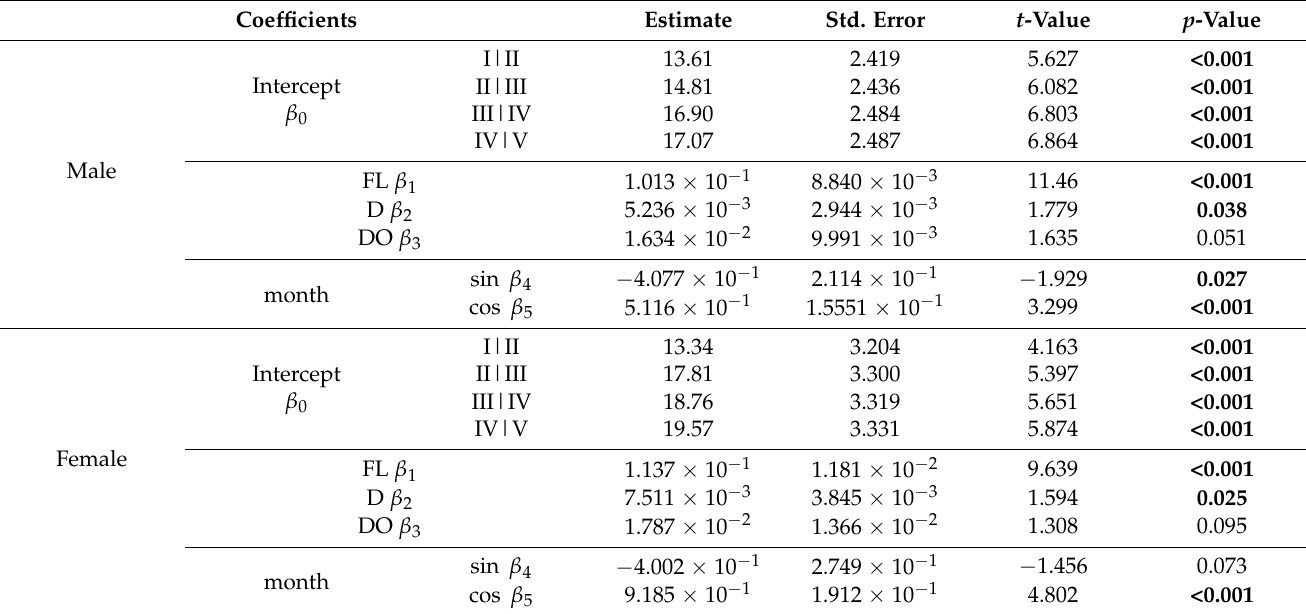
Table 2. Fitting results of multiple ordered logistic model for sexual maturity grade and influencing factors. Significant p -values are formatted in bold